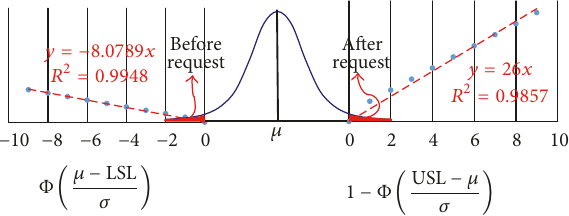
Figure 3: Cost of delivery time in the delivery time